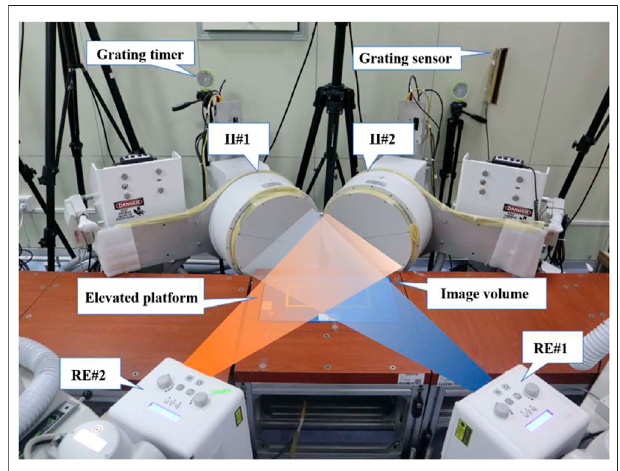
FIGURE 2 | High-speed DFIS set-up. Participants ran on an elevated platform.Imageintensi fi ers(II#1andII#2)processedimagescreatedbyX-rays from the radiographic emitters (RE#1 and